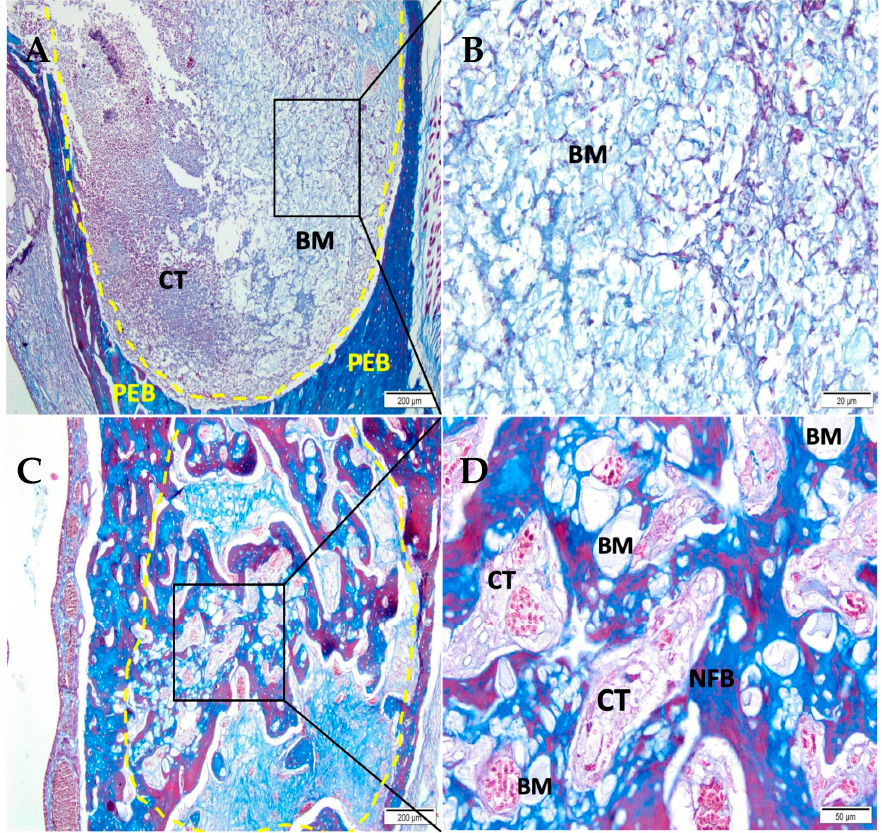
Figure 4. Photomicrographs of the CHA-M group 7 and 42 days after alveolar grafting. ( A , B ): 07 days; ( C , D ): 42 days; ( A , C ): 10× magnification of (Bar: 200 μ m); ( B , D ): 40× magnification (Bar: 50 μ m); Stain: Masson’ trichrome. Biomaterial (BM); Connective Tissue (CT); Newly Formed Bone (NFB), and Pre-Existing Bone (PEB).